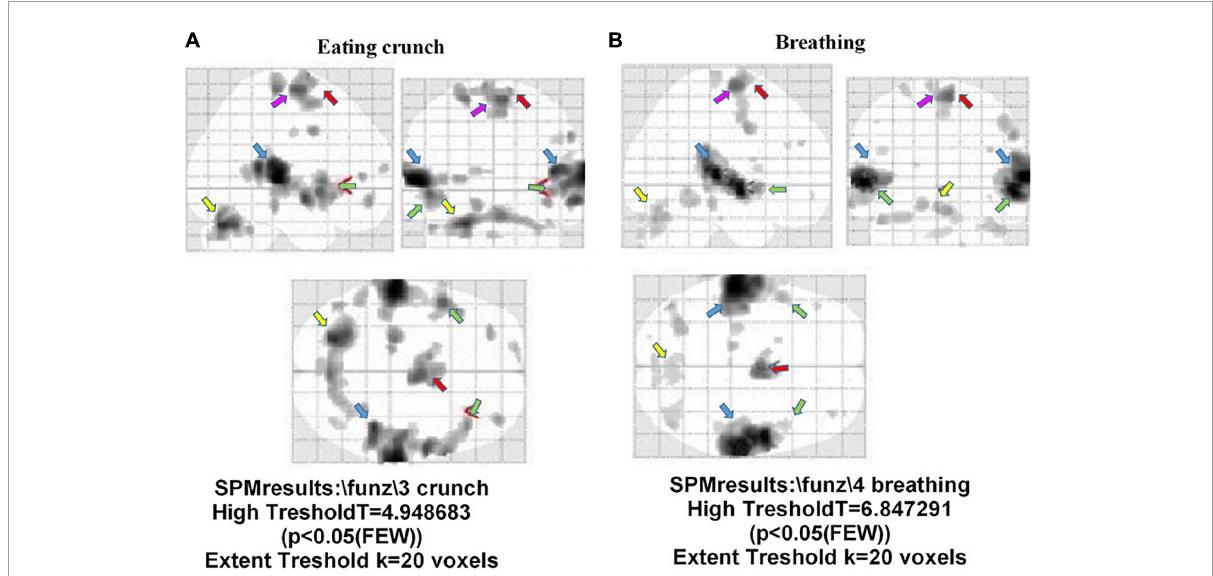
FIGURE6 Brain areas activated during the trigger sounds protocol in two participants with misophonia in the three planes. The trigger sounds were “eating crunchy” in panel (A) , and “breathing” in panel (B) . In panel (A) , details on left insula. Also, auditory cortex (BA 41 and 42; light blue arrow), the cerebellum (yellow arrow), the insula (green arrow), the premotor cortex (BA 6; red arrow), and the frontal cortex (BA 4; pink arrow) were activated during the trigger sounds protocol. In panel (B) , the areas identified were the auditory areas (BA 41 and 42; light blue arrow), the cerebellum (yellow arrow), and the premotor cortex (BA 6; red arrow).